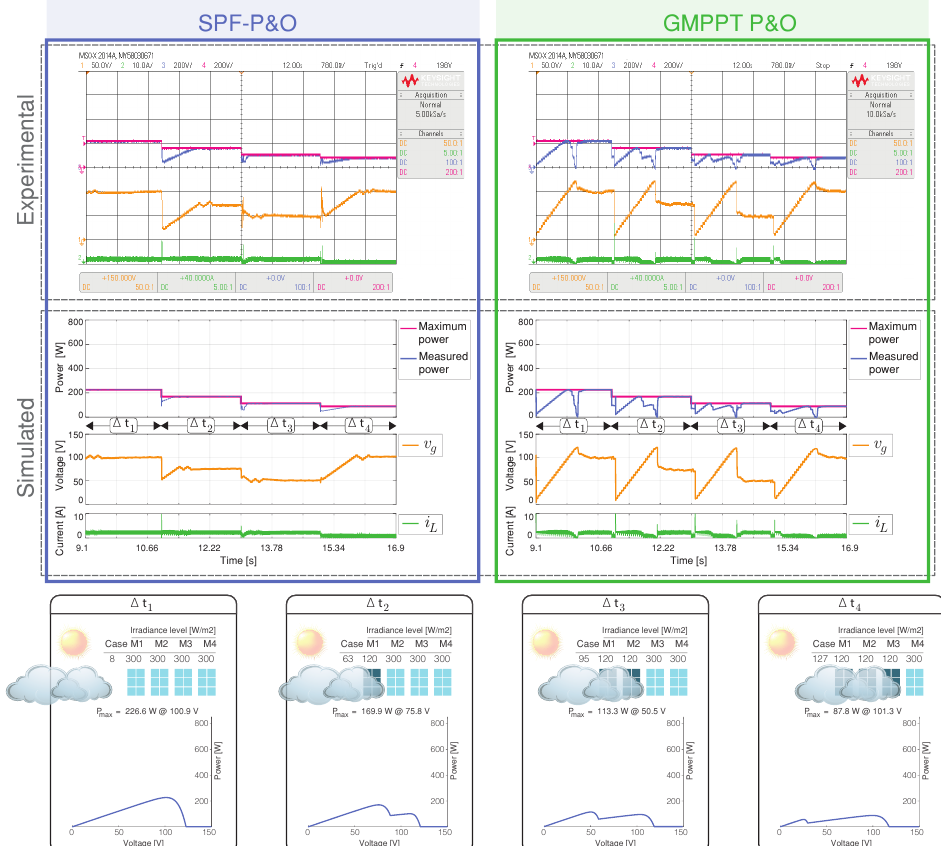
Figure 15. Simulated and experimental dynamic behavior of the MPPT algorithms for Scenario 6 with an output voltage V o = 160 V. The proposed MPPT algorithm (right) is compared with the GMPPT P&O algorithm (right). CH1: v g (50 V/div), CH2: i L (10 A/div), CH3: Maximum power (200 W/div), CH4: Measured power (200 W/div) and a time base of 780 ms. RE MAE